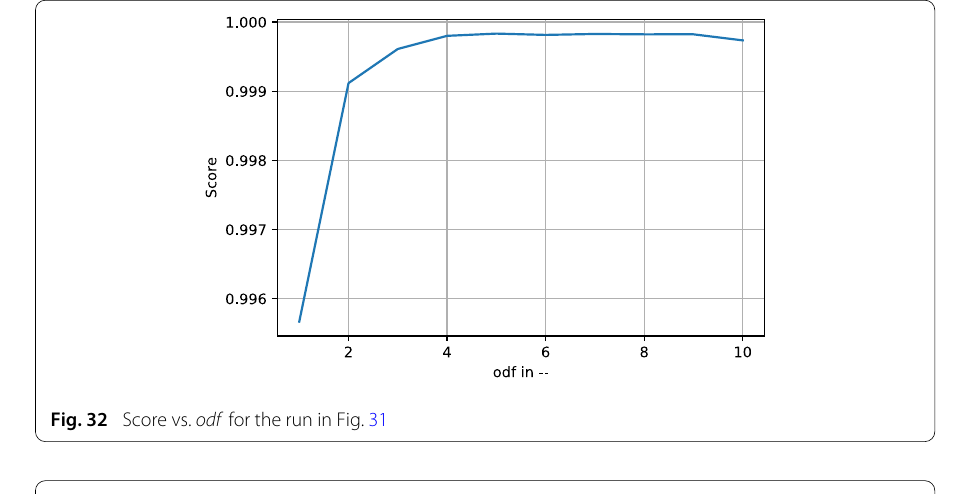
Fig. 32 Score vs. odf for the run in Fig. 31